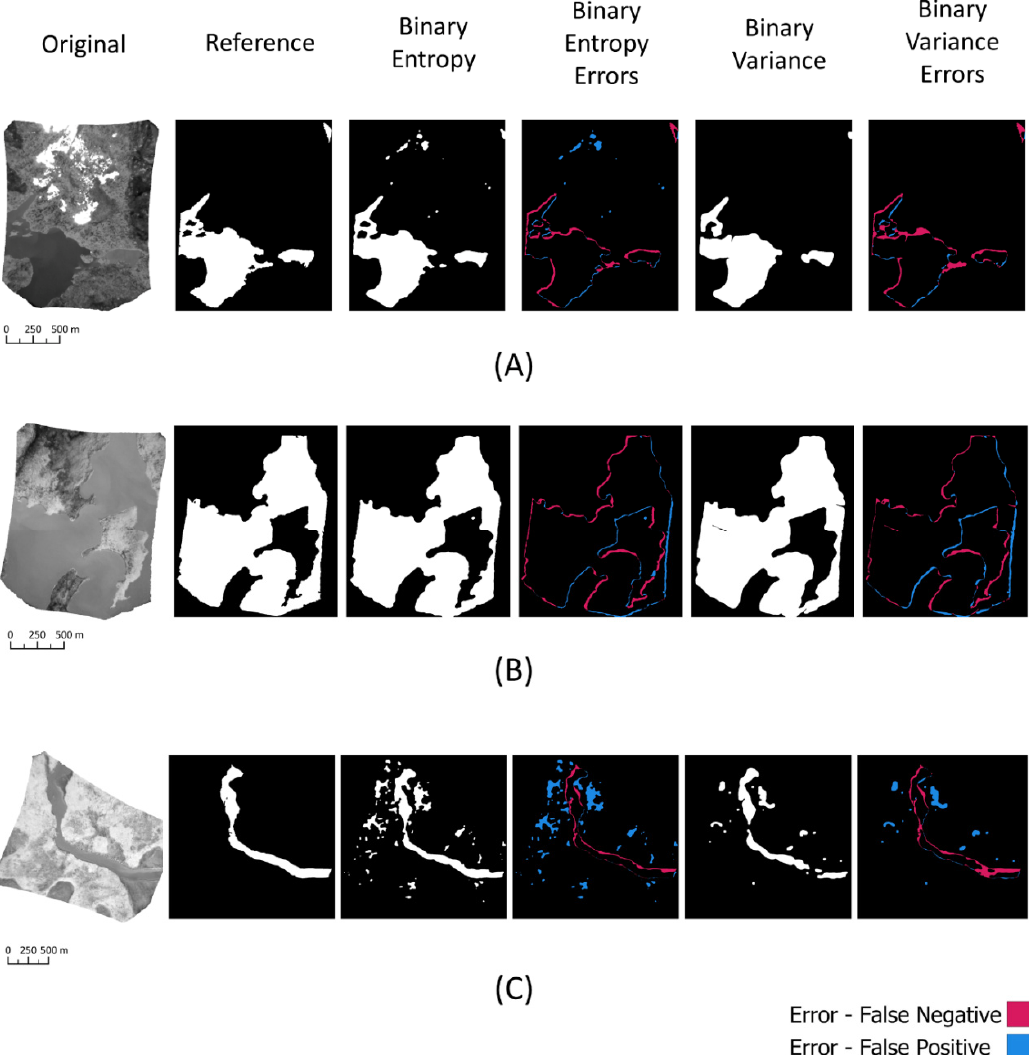
Figure 7. Sample segmentation for binary entropy and binary variance ( A ) BE more accurately captures shorelines at the expense of additional false positives, including within areas of active fire; ( B ) BV includes lines of false positives where there are visible temperature shifts in water; ( C ) Both methods are prone to false positive patches, particularly common near narrow waterbodies.